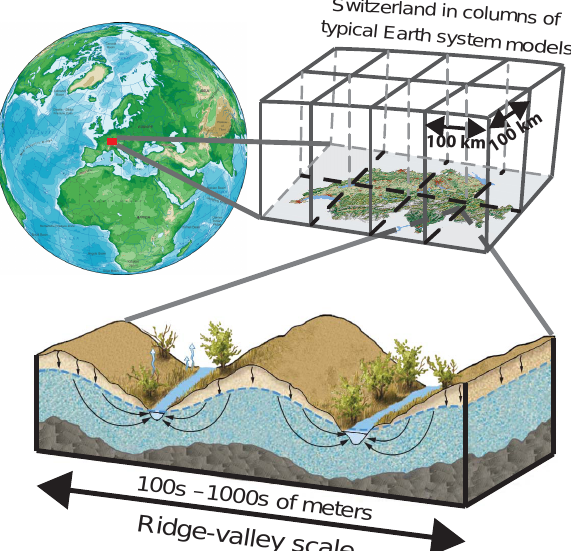
Figure 1. Sub-grid-scale surface heterogeneity and subsurface wa- ter redistribution are unrepresented in Earth system models. At the 100km by 100km grid cell scale, large mountain ranges (such as the Swiss Alps) become